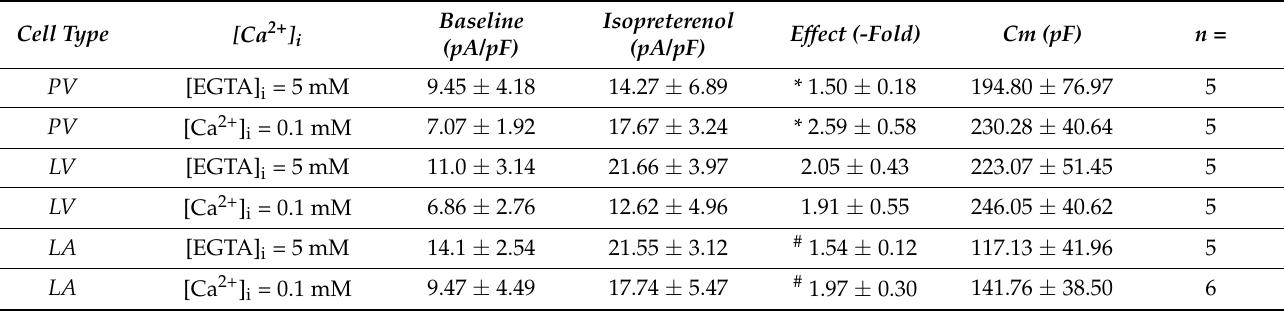
Table 3. Comparison of L-type Ca 2+ current amplitudes under different conditions. The current amplitudes are an average of three stably recorded sweeps. Baseline and Isoproterenol conditions indicate the current amplitudes in the absence and presence of 1 µ M isoproterenol, respectively. The amplitude in the presence of isoproterenol is divided by the baseline to calculate the effect. Statistical p -values for the differences between the values are given below the table. PV, pulmonary vein; LA, left ventricle; LA, left atrium; Cm, membrane cell